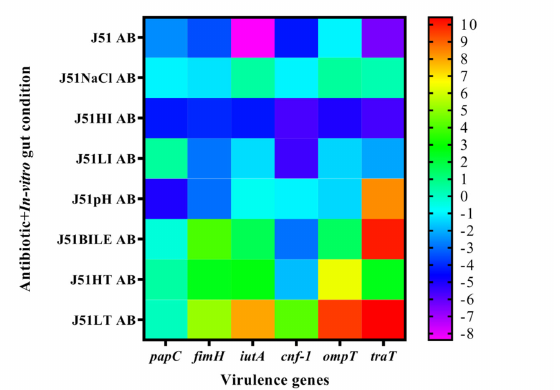
Figure 5. The expression level of virulence genes on exposure to antibiotic + in vitro gut conditions in J51 are presented using fold change values transformed to log2 format. The color scale indicating log2 (fold ‐ change values) is shown towards the right of the heat map.